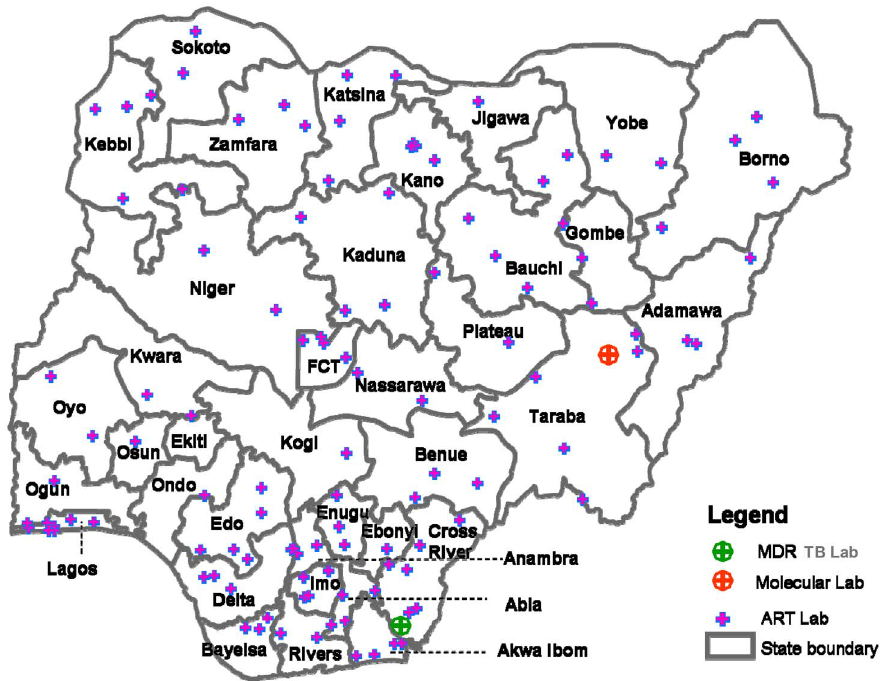
Figure 1. Study Sites: A wide network of FHI360 supported laboratories in Nigeria.